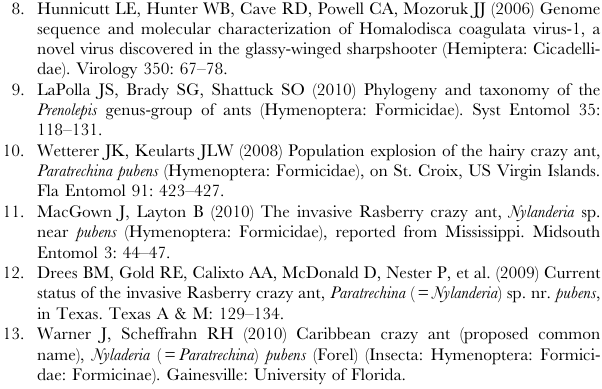
Table S1 N. pubens transcriptome sequences yielding a non-significant ( . 1e 2 4 ) expectation score from BLAST analysis with viral identity. Each sequence designation, corresponding BLAST results (gene and virus relatedness), and characteristics (nucleic acid composition, family and host range) are provided. DNA viruses are consolidated in the upper panel and RNA viruses in the lower